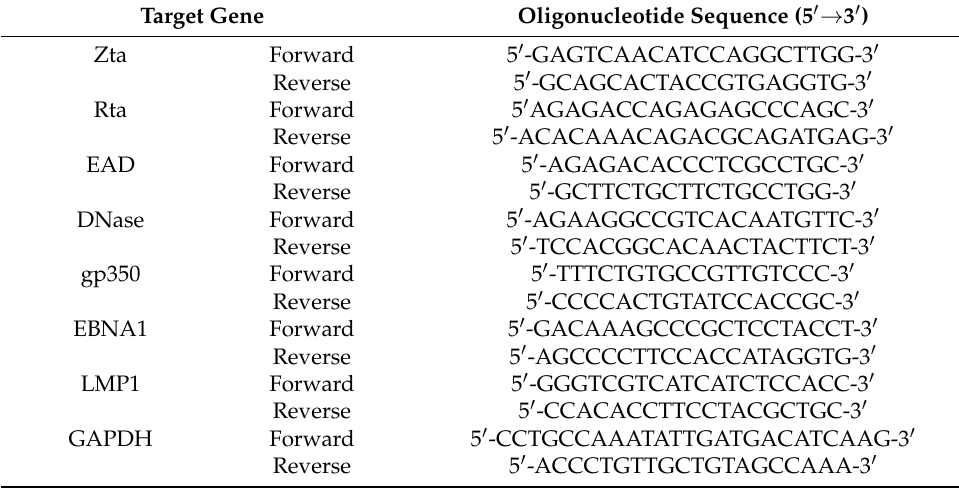
Table 1. List of primers used for amplification qRT-PCR. Target